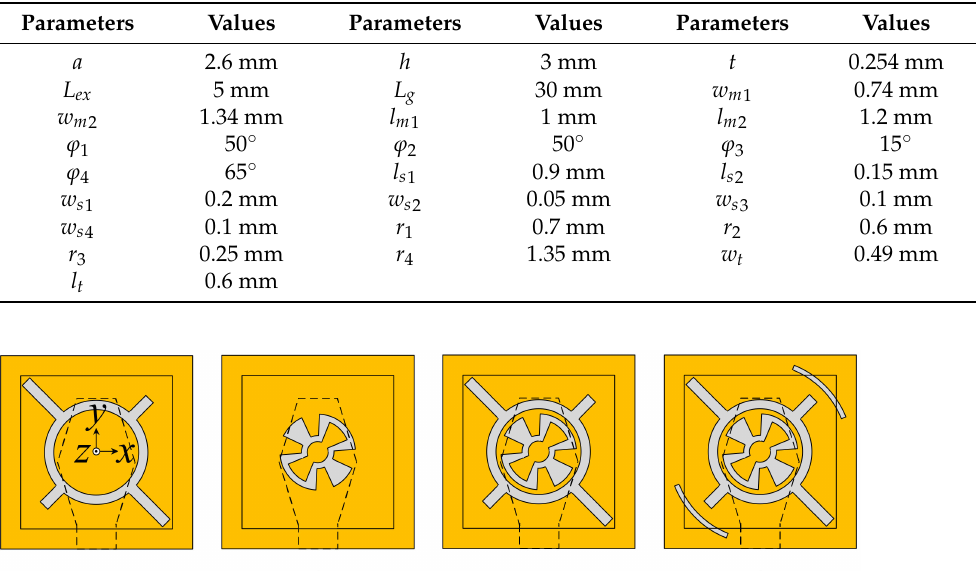
Table 1. Geometric parameters of the proposed DRA.